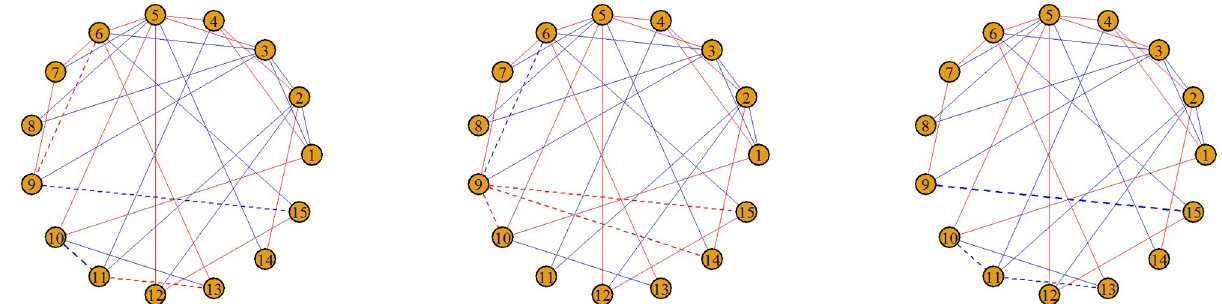
Fig 1. Simulated networks for N = 3 subjects under the “cohort” method. Solid lines between nodes represent population edges and dashed lines represent subject-specific edges. Red edges represent a positive association between edges while blue edges represent negative associations. The following command was used: gen.Network(method = “cohort”,p = 15,Nsub = 3,sparsity = 0.2,REsize = 10, REprob = 0.5,REnoise = 1).